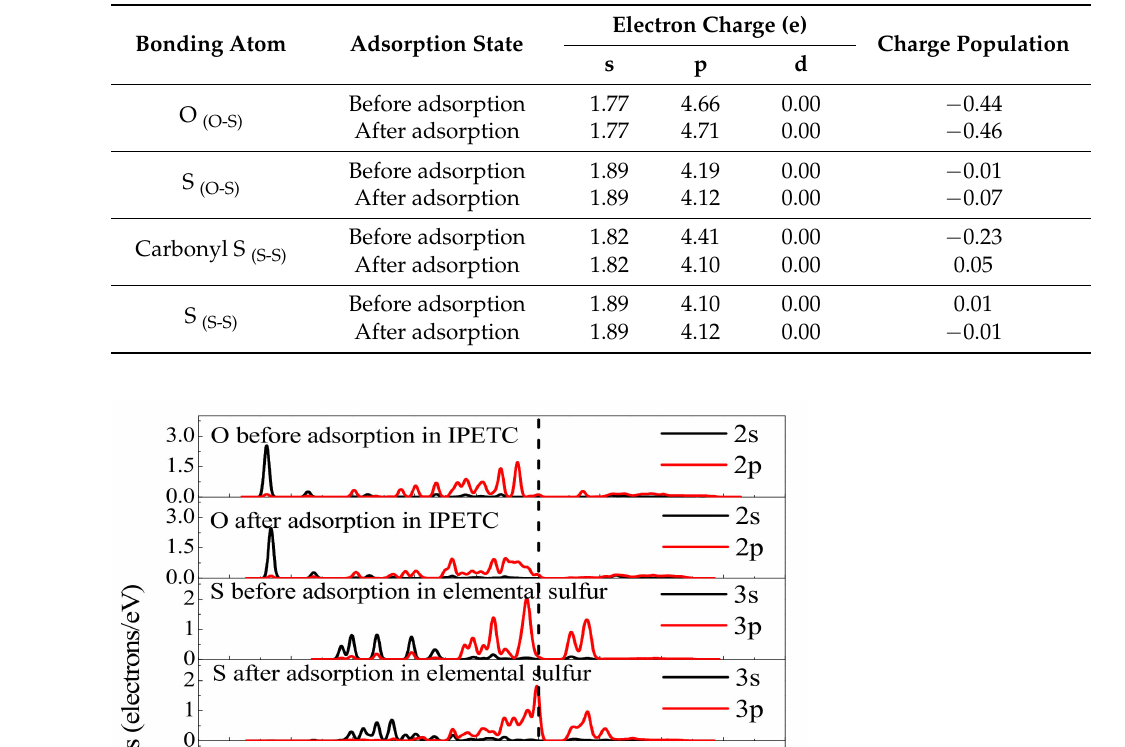
Table 13. Mulliken charge populations of bonding atoms before and after adsorption.